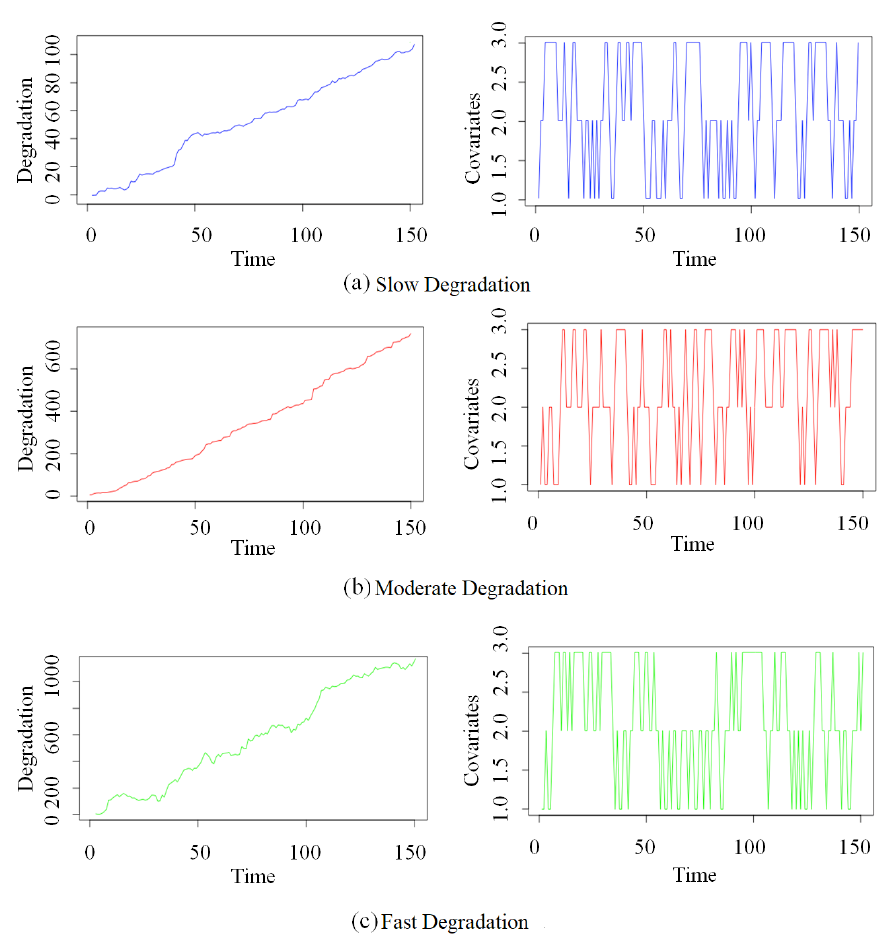
Figure 5. Degradation paths and covariates for different degradation states based on real